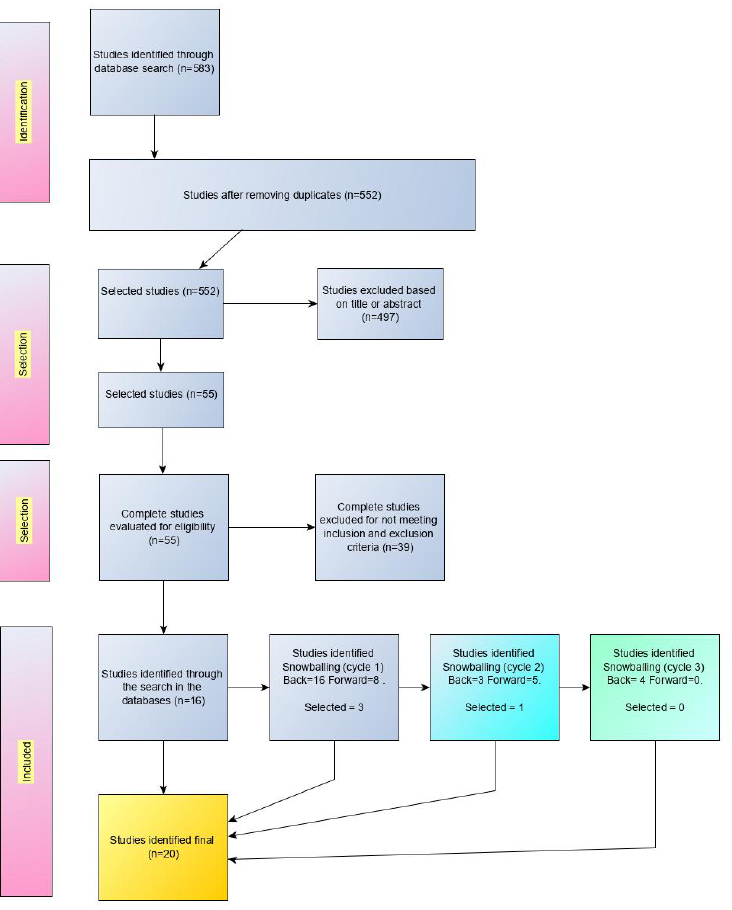
Figure 3. Selection